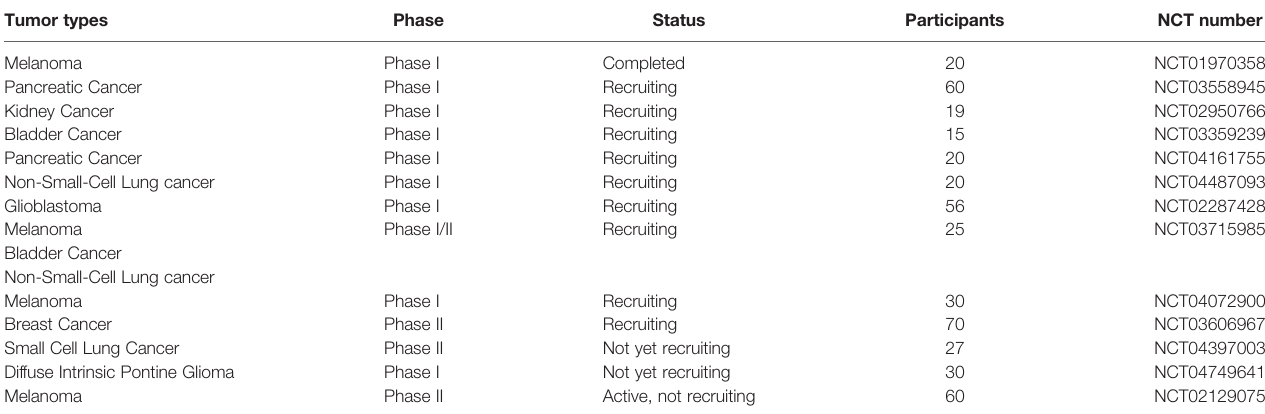
TABLE 1 | The clinical application of personalized neoantigen